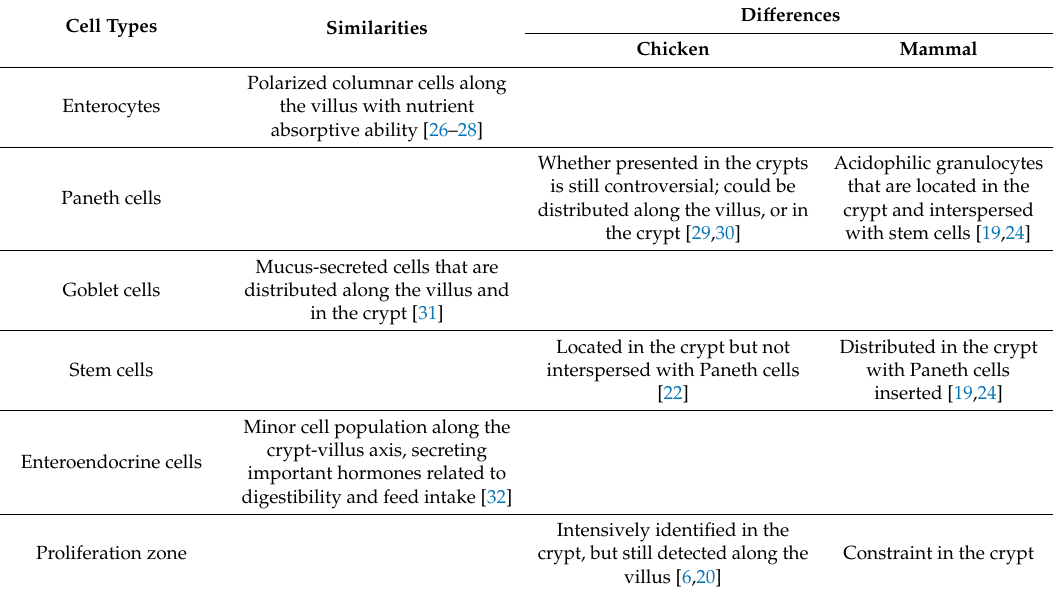
Table 1. Similarities and di ff erences of chicken small intestinal epithelium compared with